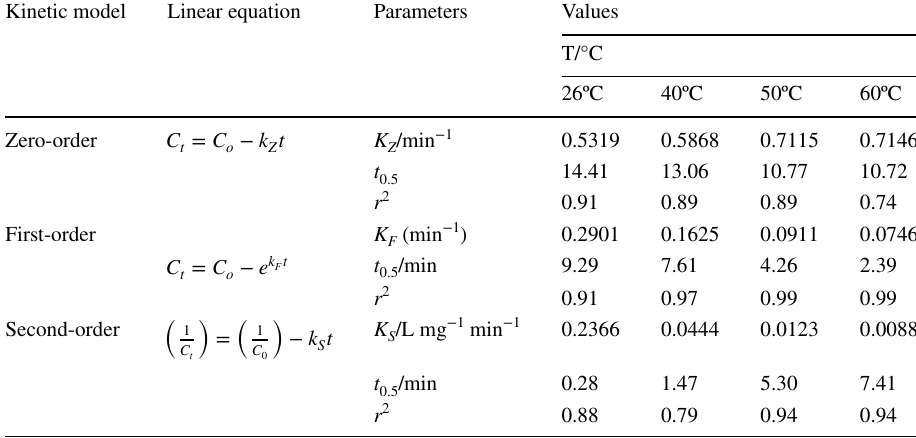
Table 5 Photocatalytic kinetic models and statistical analysis of Synozol Blue oxidation